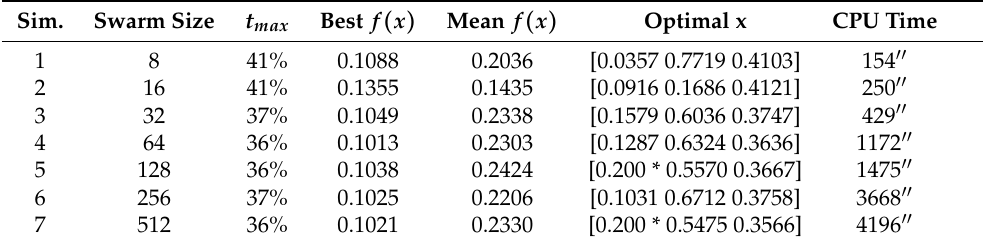
Table 3. Particle swarm optimization summary. Run in a computer with Intel Core i7-10700 processor @2.90 GHz and 16.0 GB RAM @2933 MHz, all simulations using 8 thread parallelization. * Value falling in a limit of the optimization ranges (13).